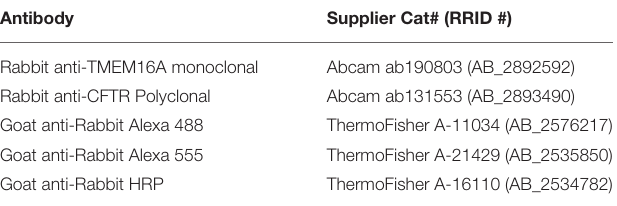
TABLE 1 | Antibodies. Antibody Supplier Cat# (RRID #) Rabbit anti-TMEM16A monoclonal Abcam ab190803 (AB_2892592) Rabbit anti-CFTR Polyclonal Goat anti-Rabbit Alexa 488 Goat anti-Rabbit Alexa 555 ThermoFisher A-21429 (AB_2535850) Goat anti-Rabbit HRP